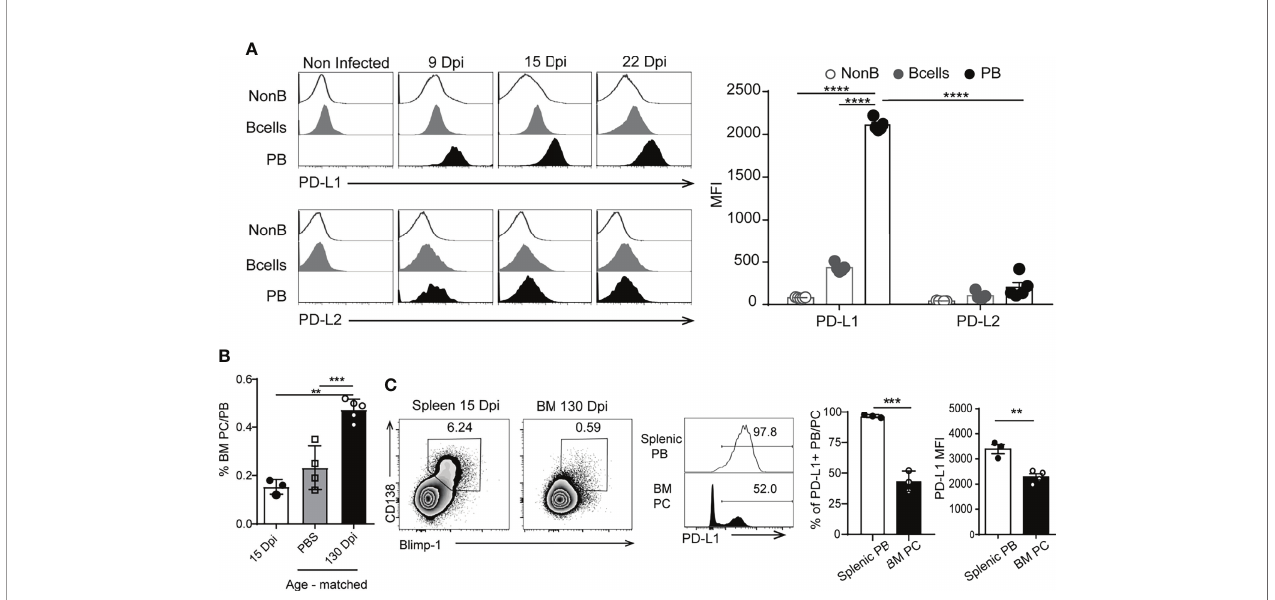
FIGURE 2 | Plasmablasts from T. cruzi -infected mice expressed high levels of PD-L1. (A) Representative histograms of PD-L1 or PD-L2 expression on splenic non- B cells (CD19 - CD138 - B220 - ), B cells (CD19 + CD3 - CD138 - B220 + ) from non-infected mice (n=5) and T. cruzi -infected C57BL/6 mice (n=5) and on plasmablasts (PB) (CD19 int B220 low CD138 hi ) from T. cruzi -infected C57BL/6 mice evaluated at 9, 15 and 22 Dpi. Statistical analysis of mean fl uorescence intensity (MFI) of PD-L1 or PD-L2 on the mentioned cells analyzed at 15 Dpi. ****p<0.0001 one-way ANOVA, Bonferroni post hoc test. (B) Statistical analysis of the frequency of PB/PC (plasma cell) CD138 + Blimp-1 + of live single lymphocytes (gated on IgD - IgM - CD11b - CD24 - ) from bone marrow (BM) obtained at 15 Dpi (white bar) and at 130 Dpi with T. cruzi (black bar). Cells from BM from age-matched non-infected mice, injected with PBS, were used as controls (gray bar). (C) Representative plots of CD138 vs Blimp-1 of live single lymphocytes (gated on IgD - IgM - CD11b - CD24 - ) from spleen and bone marrow (BM) obtained at 15 Dpi and 130 Dpi with T. cruzi , respectively. Representative histograms of PD-L1 on gated CD138 + Blimp-1 + B220 + cells. Numbers in histograms indicate the percentage of PD-L1 + cells. Bar graph shows statistical analysis of the frequency of PD-L1 + PB/PC and MFI of PD-L1 + on splenic PB from 15 Dpi-Tcruzi infected mice (white bar) and 130 Dpi-BM plasma cells (PC). **p<0.01, one-way ANOVA, Bonferroni post hoc test. Data in (A, B) are representative of three independent experiments. ***p <